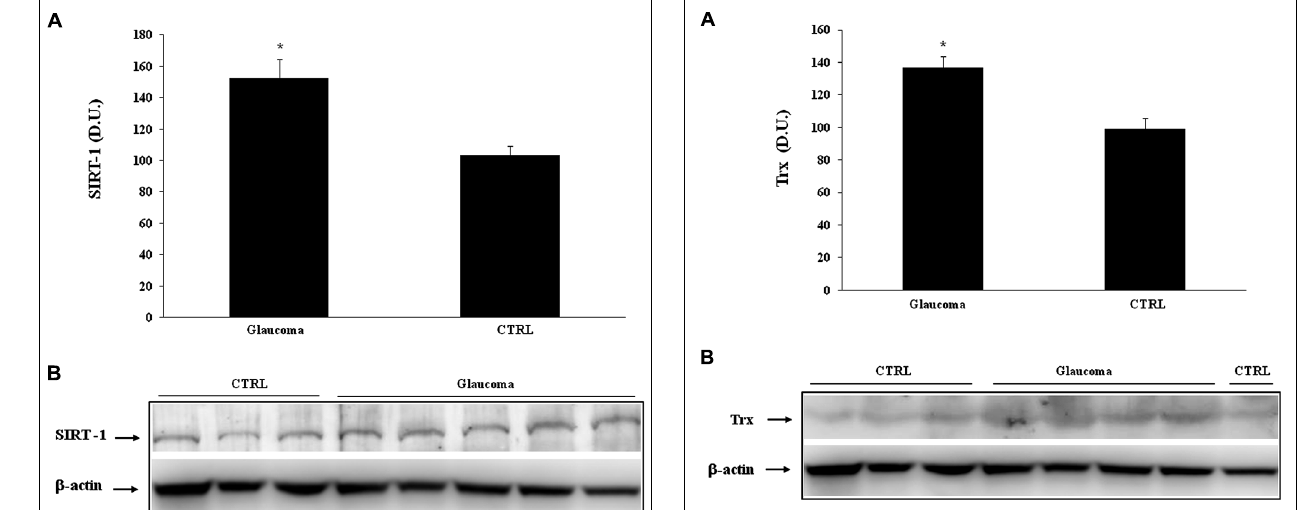
FIGURE 6 | (A) Sirtuin-1 protein levels in lymphocytes of glaucoma and control subjects. Samples from control and patients with glaucoma were assayed for Sirt-1 expression byWestern blot. A representative immunoblot is shown. β -actin has been used as loading control. (B) Densitometric evaluation: the bar graph shows the values are expressed as mean standard error of mean of 3 independent analyses. * P < 0.05 vs. control. D.U., densitometric units; CTRL, control.